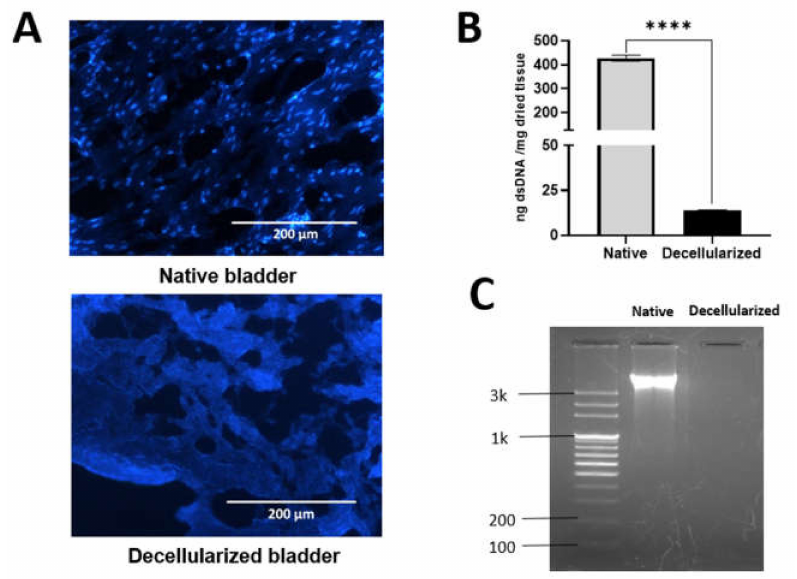
Figure 1. Decellularization efficiency. ( A ) DAPI stain (scale bar 200 µ m). ( B ) dsDNA content by Picogreen assay ( n = 3). ( C ) DNA electrophoresis. **** denotes a statistically significant difference ( p <